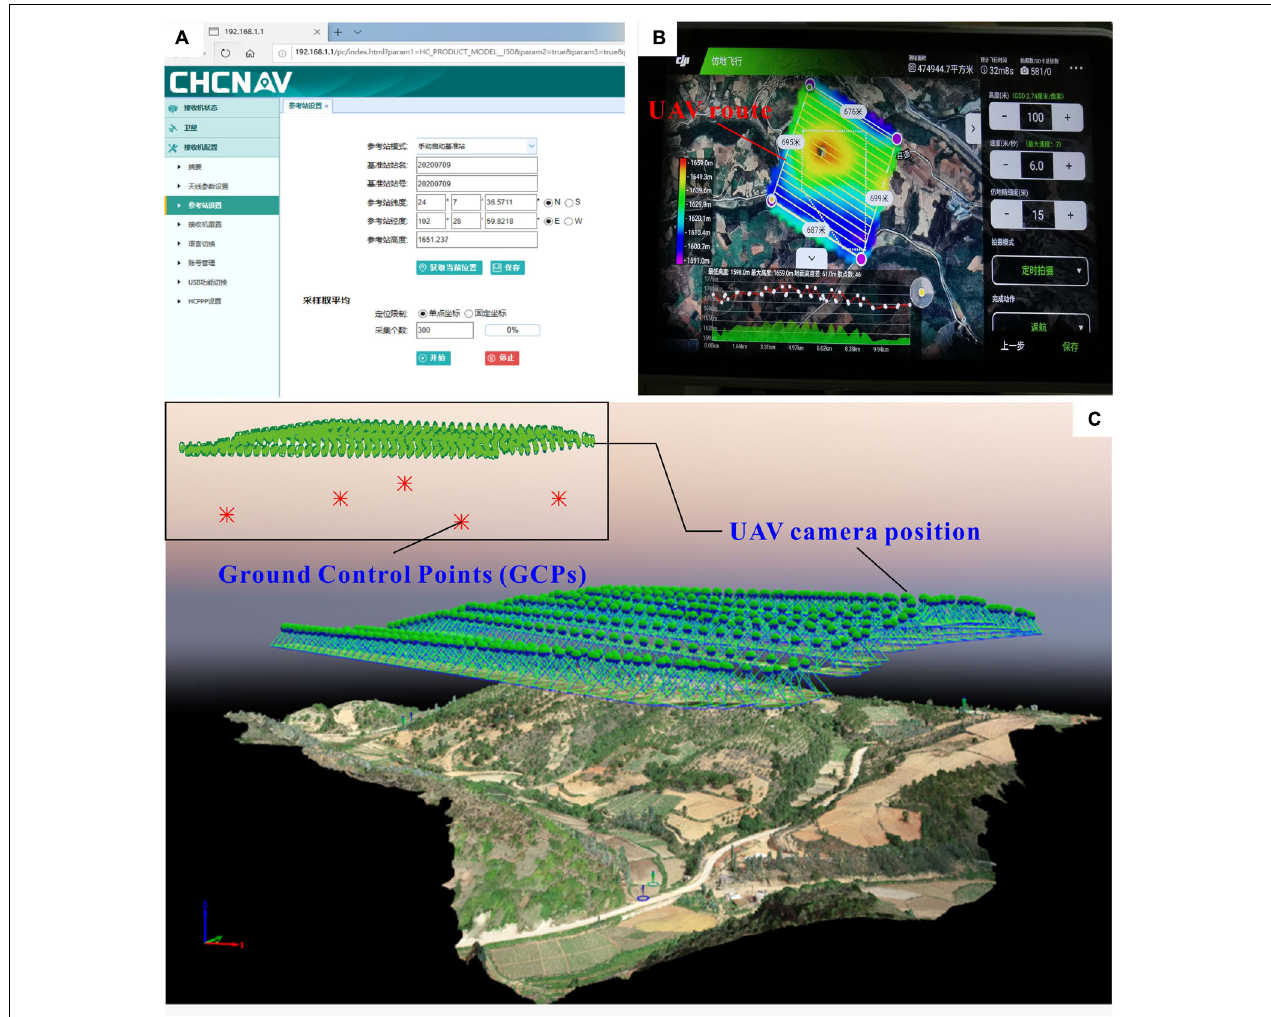
FIGURE 4 | UAV route planning: (A) Parameter setting of measuring base station, (B) Route planning interface of UAV ground station, and (C) Camera location, GCPs, and 3D model.